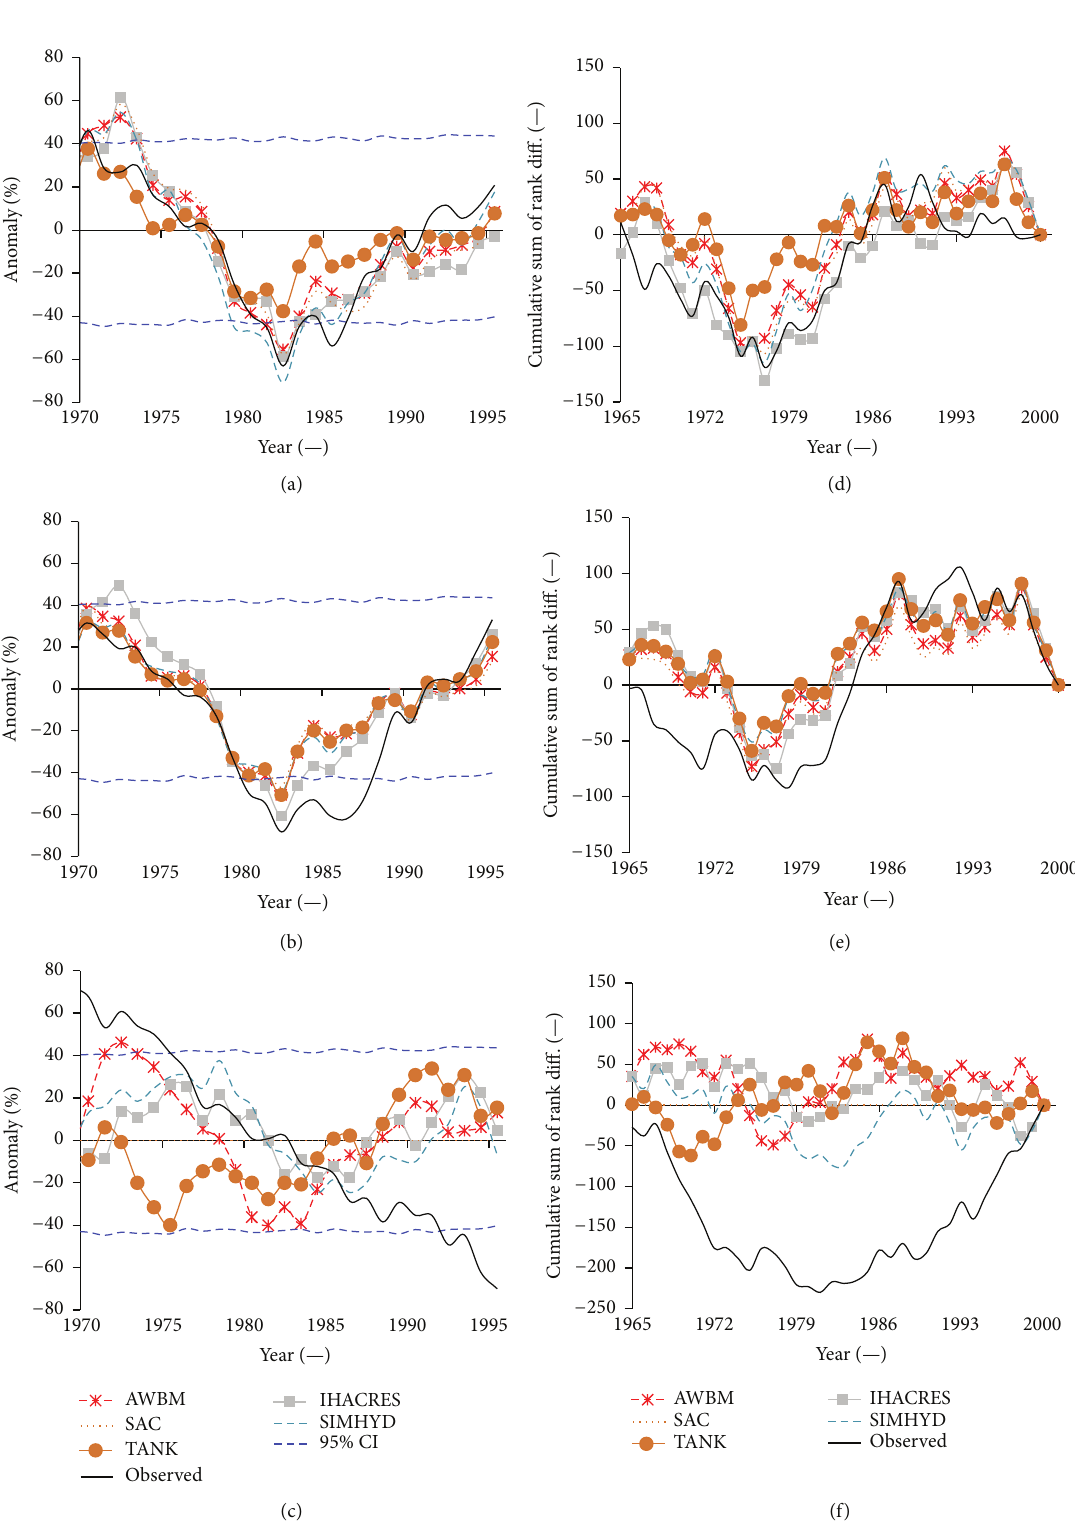
Figure 10: Temporal variation in terms of (a)–(c) NAIM results and (d)–(f) CRD results for (a, d) maximum flow in each year, (b, e) mean